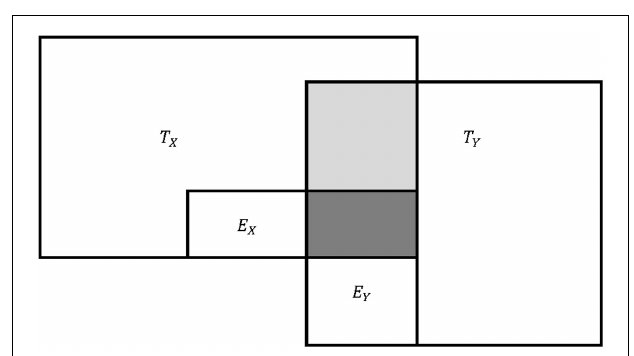
FIGURE 2 | Conceptual representation of observed score variance in the case of correlated error.T , true scores; E , error scores. Note: lighted shaded area denotes shared variance between T X and T Y . Dark shaded area denotes shared variance between E X and E Y